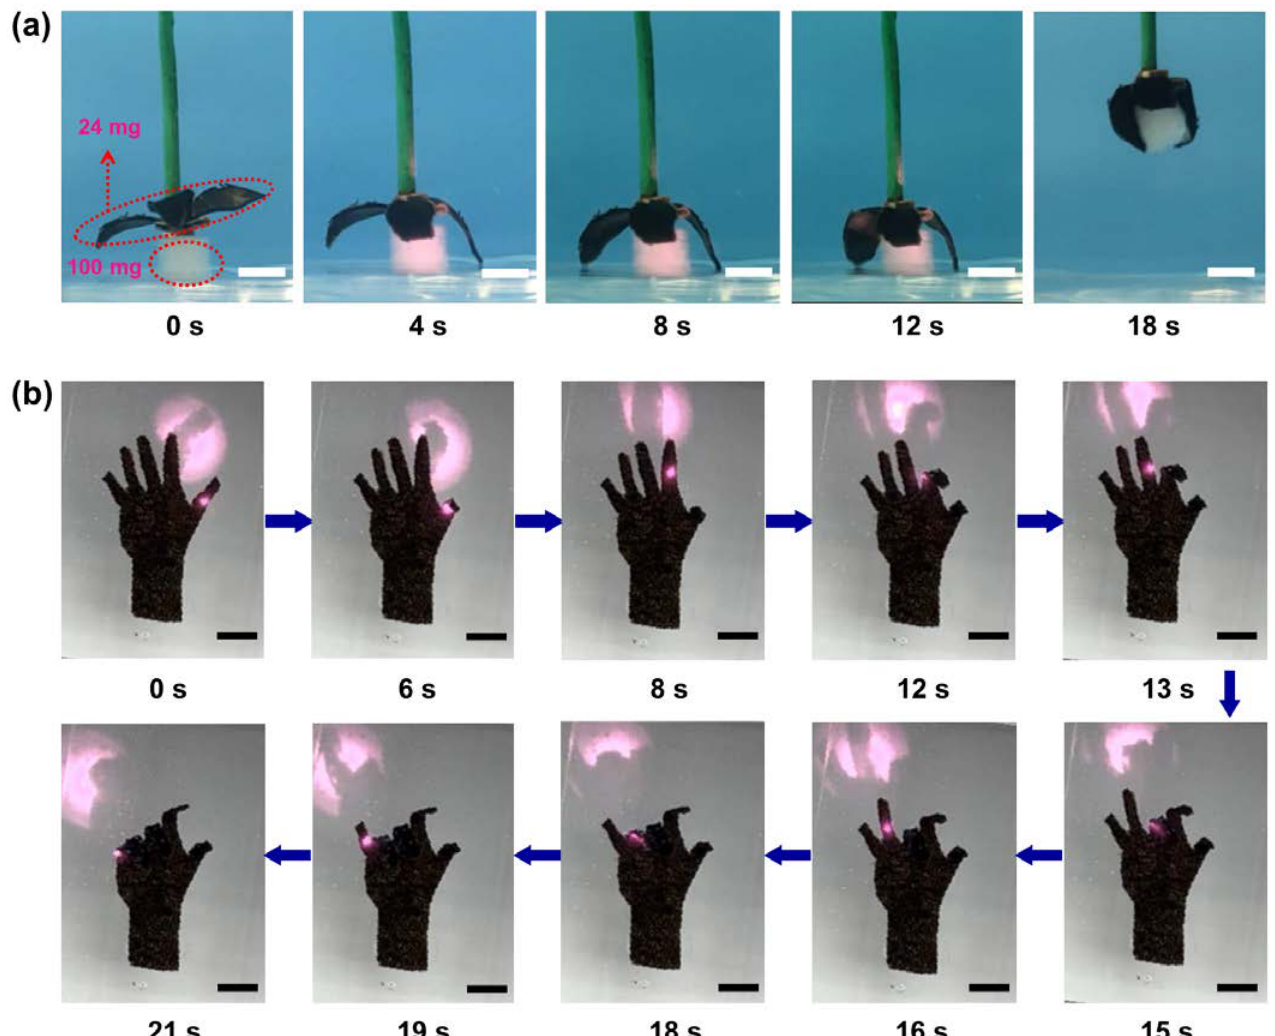
Figure 5. ( a ) The remotely controlled light-responsive grabbing behavior of the biomimetic “paw” based on the composite actuator under an area irradiation (with a 1 cm spot diameter and 5 W of power by an 808 nm laser). ( b ) The remotely controlled light-responsive finger-folding performance of the biomimetic “hand” based on the composite actuator under a point irradiation (with a 0.2 cm spot diameter and 2 W of power by an 808 nm laser).